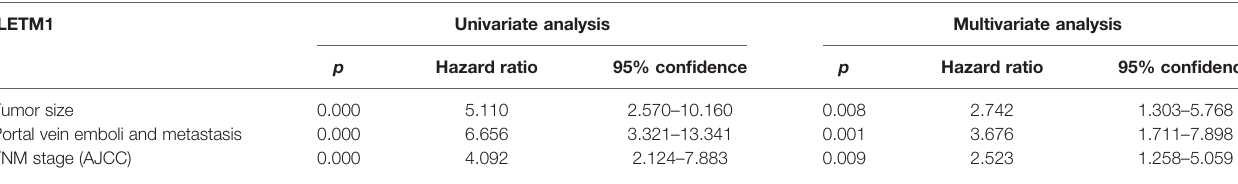
Frontiers in Oncology |